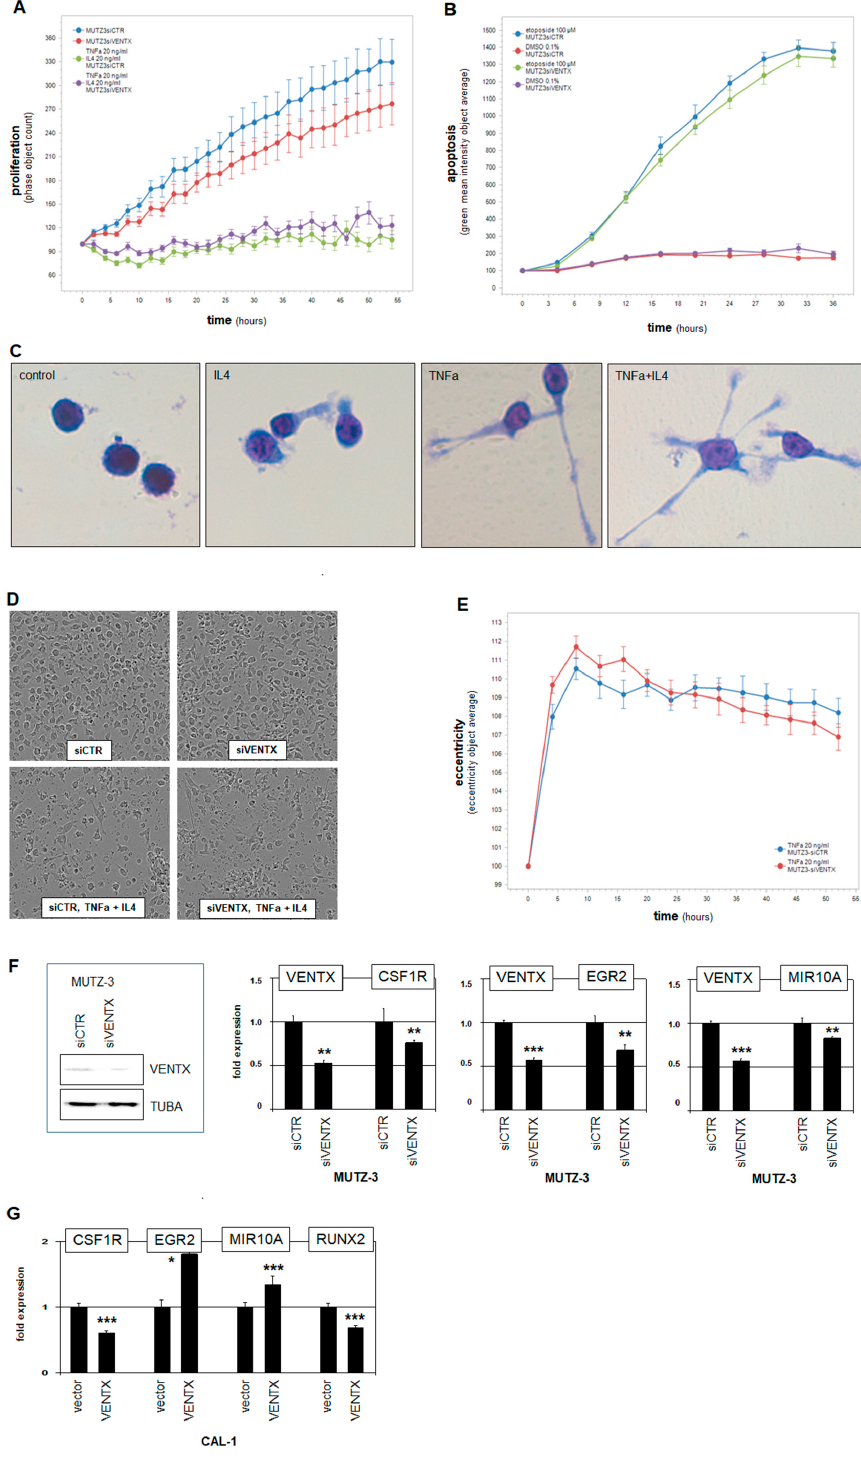
Figure 6. Functional analyses of VENTX. ( A ) MUTZ-3 cells treated for siRNA-mediated knockdown of VENTX